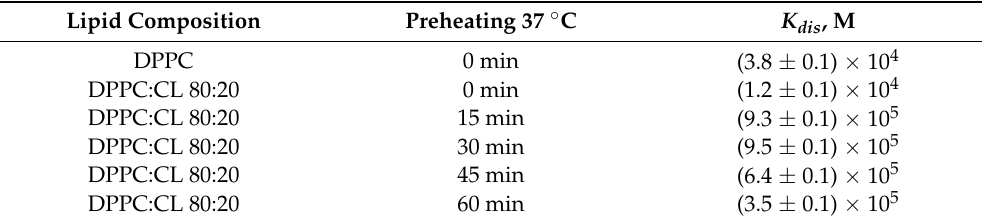
Table 2. K dis of complexes of gel-like liposomes and ChitMan with and without preheating. 0.02 M Na-phosphate buffer solution, pH 7.4, 22 ◦ C. SD, n =